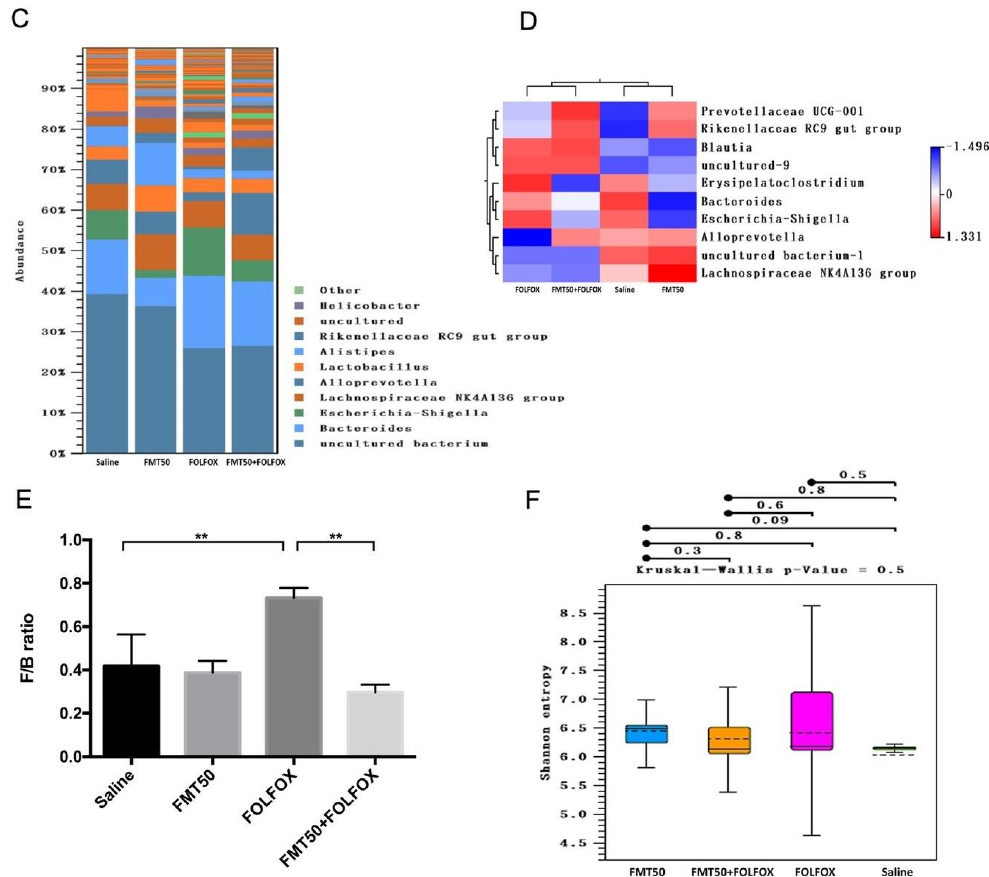
Figure 7. Changes in fecal gut microbiota of subcutaneously injected colorectal cancer mice presenting FOLFOX-induced intestinal damage with/without FMT ( n = 5 for each group). The composition of gut microbiota was determined by the following: ( A ) bar charts, ( B ) heatmap of the relative abundance of gut microbiota at the phylum level, and ( C ) bar charts, ( D ) heatmap at the genus level, ( E ) abundance of Firmicutes-to-Bacteroidetes ( F / B ) ratio and ( F ) Tukey box plots of α-diversity. FMT50: 50 mg/mL. Values are presented as the mean ± SEM. **: p < 0.01.